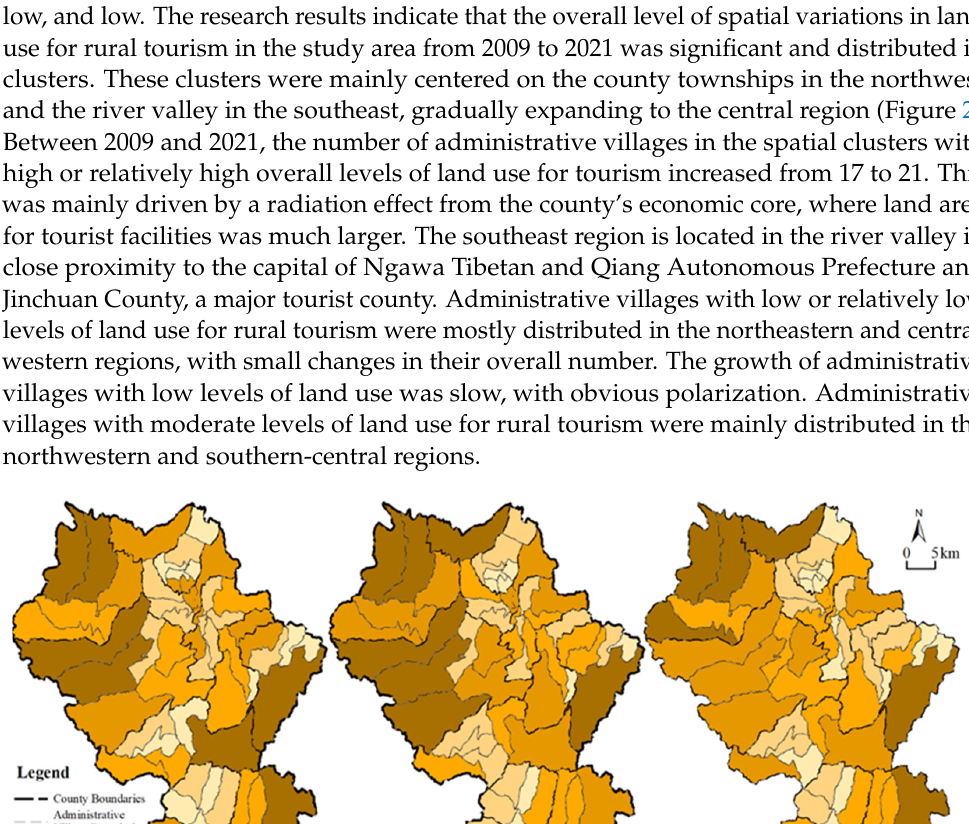
Figure 1. Moran sca tt er plot of the overall level of rural tourism land in the study area in 2021 ( a ), 2015 ( b ), 2009 ( c ).